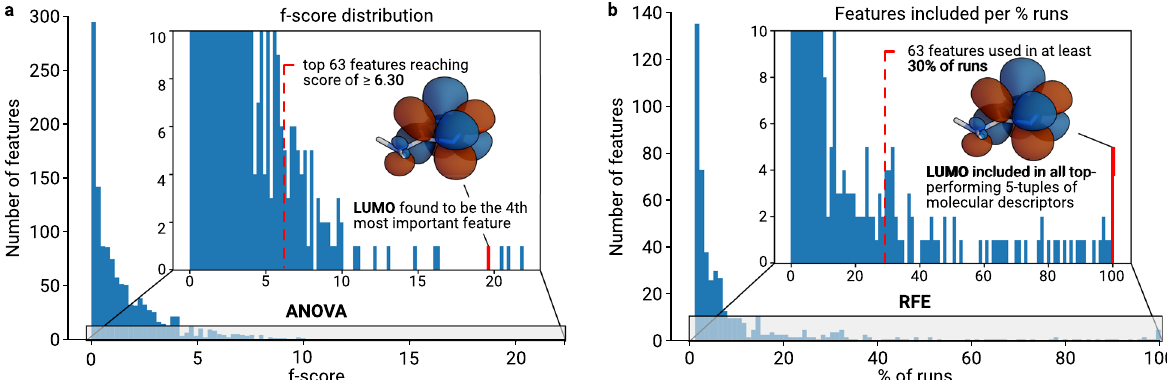
Fig. 2 Feature distributions. a Distribution of f -scores as calculated by ANOVA. The top 63 features reach a score of 6.3 or higher, with only 11 features scoring 10 or above. b The recursive feature elimination (RFE) identi fi es a total of 504 features over a series of 100 runs with random initialization as potential candidates for a top 63-tuple. Selecting among them those identi fi ed in at least 30% of the runs (frequency analysis) can be used to de fi ne the most relevant 63